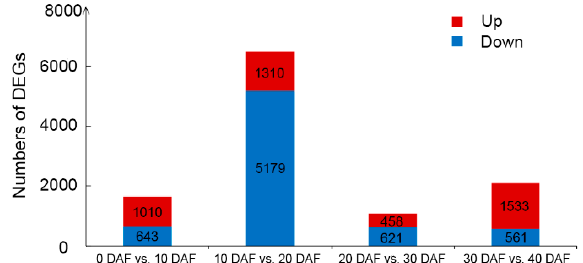
Figure 2. Numbers of differently expressed genes (DEGs) in comparison with the soybean developing seeds between adjacent developmental stages. DEGs were determined using the thresholds of FDR ≤ 0.05 and log2|Fold change| ≥ 1. The log2|Fold change| value of the pairwise comparison “a DAF vs. b DAF” was calculated by the formula: log2|Fold change| = log2(FPKM _ b DAF )-log2(FPKM_ a DAF ).